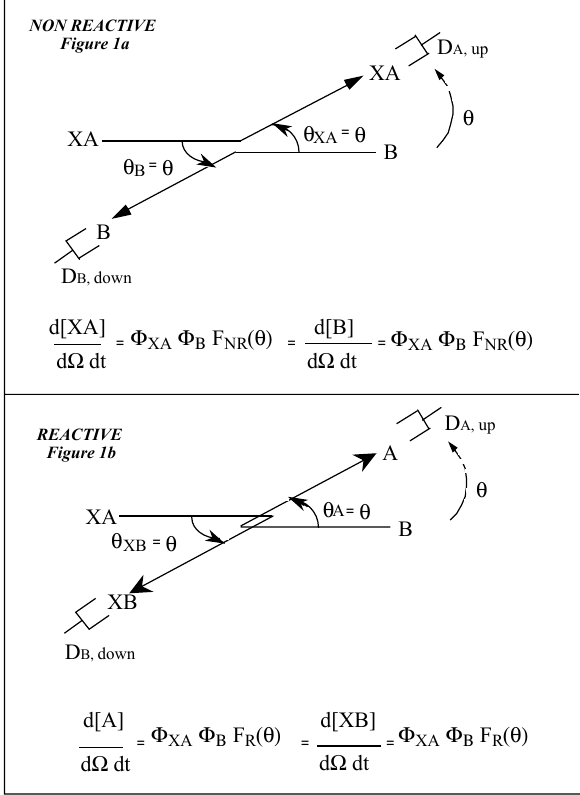
Figure 1 : F. Robert & C. Camy-Peyret in Ozone isotopic composition